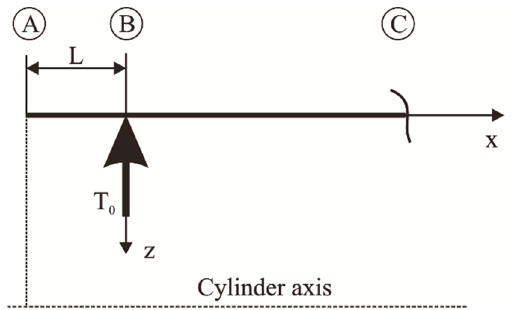
T acts at the L distance to the end of the cylinder. Figure 5. Particular case: the shear force T 0 acts at the L distance to the end of the 0